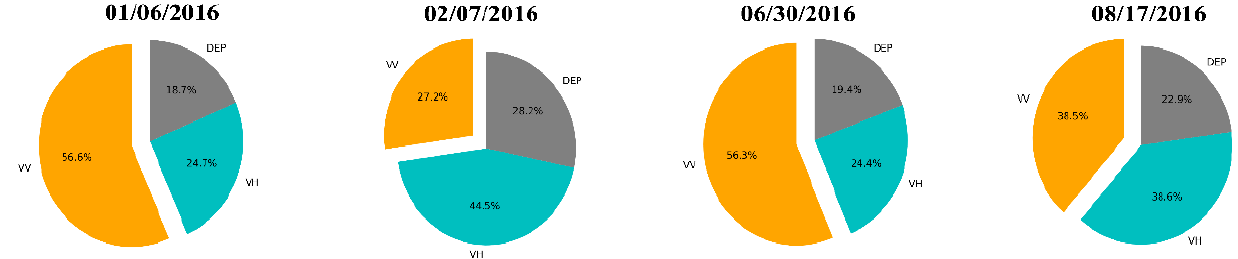
Figure 8. Feature importance for albedo estimation using the random forest algorithm for each date.